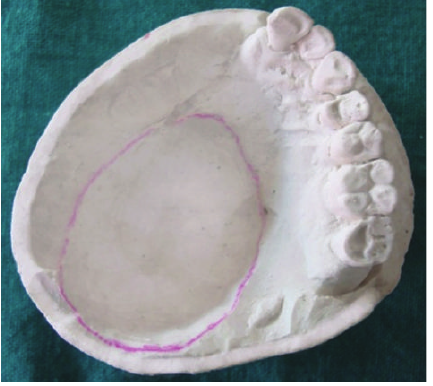
Figure 2: Restricted mouth opening.